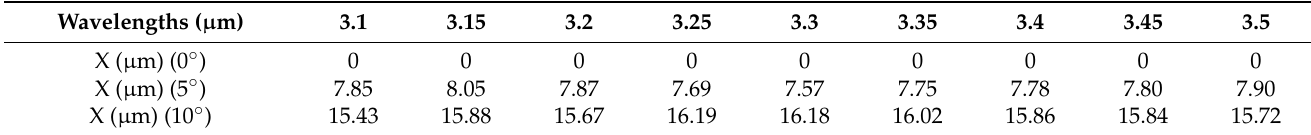
Table 5. The shifts of focal spots along X direction at the focal plane at wavelengths from 3.1 to 3.5 µ m.